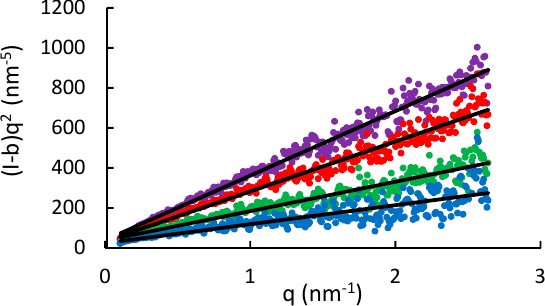
Figure 5. Linear fitting of SAXS patterns of aqueous WSCA solutions (Equation 2), at concentrations, from bottom to top, of 1, 1.5, 2, 2.5 wt%.